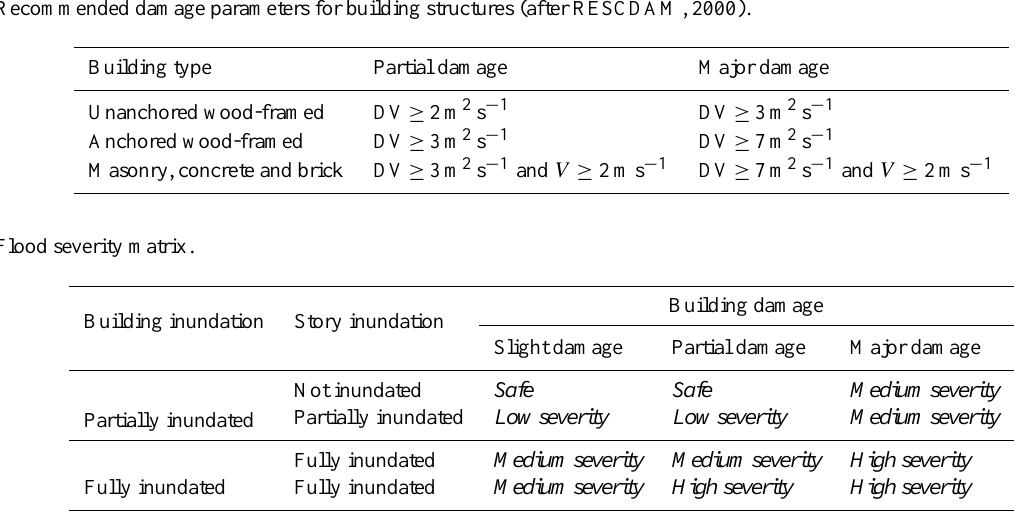
Table 2. Recommended damage parameters for building structures (after RESCDAM, 2000).